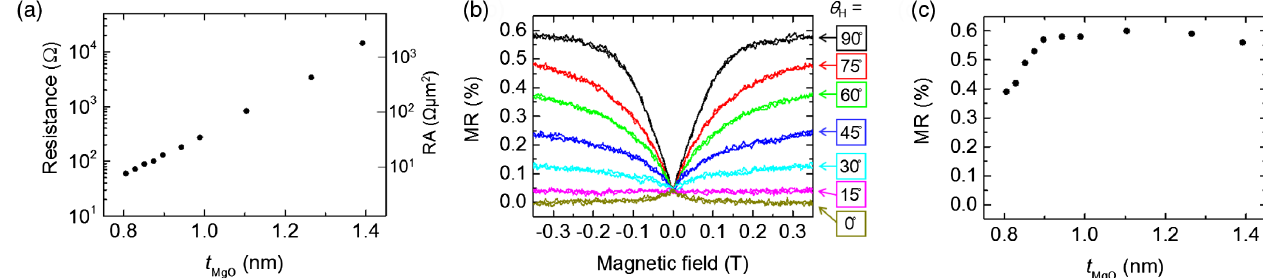
). (b) Typical TAMR, where t and resistance are MgO MgO